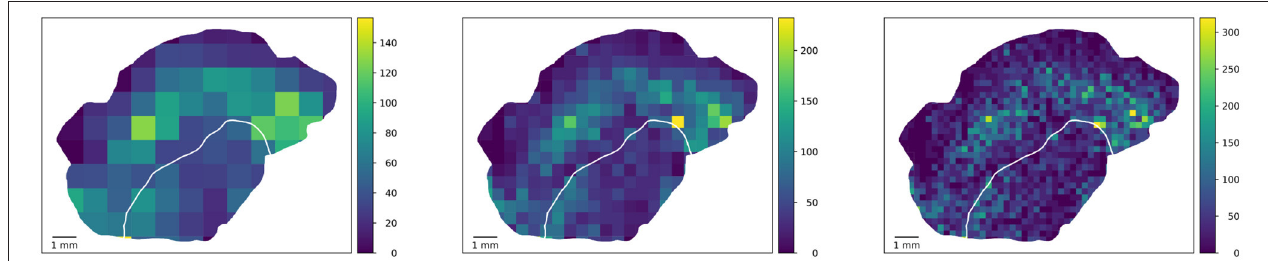
FIGURE 3 | Square-based analysis. Computing a square-based feature (density of proliferating CD8 objects) in squares of different size captures clusters of different size. Note that the color maps are scaled to a maximum range for each image separately to enhance the visibility of variability. By using measures from descriptive statistics, we quantify heterogeneity independent of spatial patterns one might observe in the tile-based